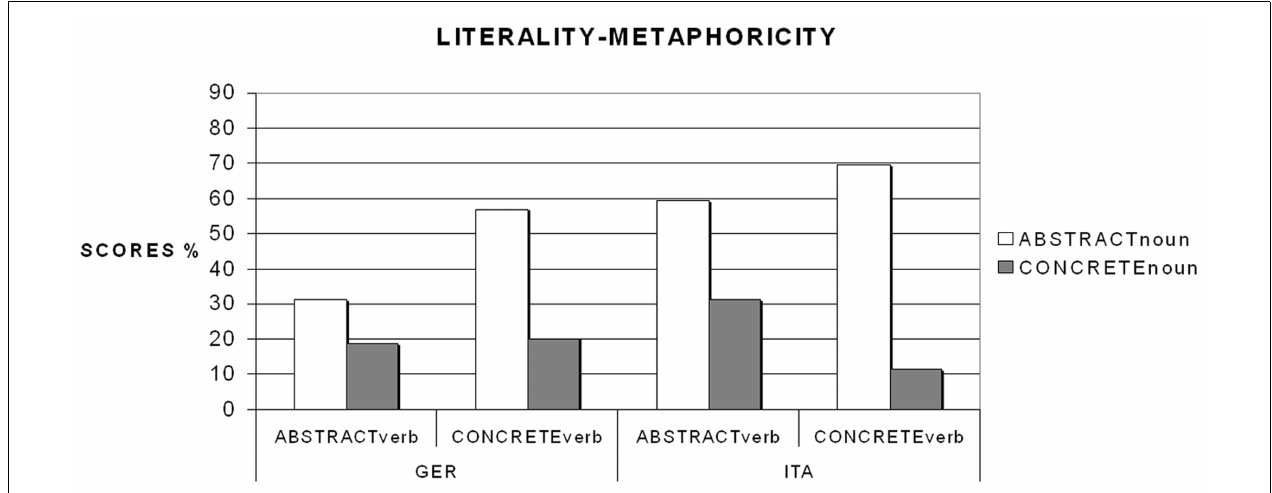
FIGURE 2 | Both groups judged the combination ConcreteVerb plusAbstract Noun as the most metaphorical one. Note: while the concrete noun meaning remains the same through the quadruples, the concrete verb meaning, as well as its concreteness/abstractness, changes through the quadruples, depending on the context.